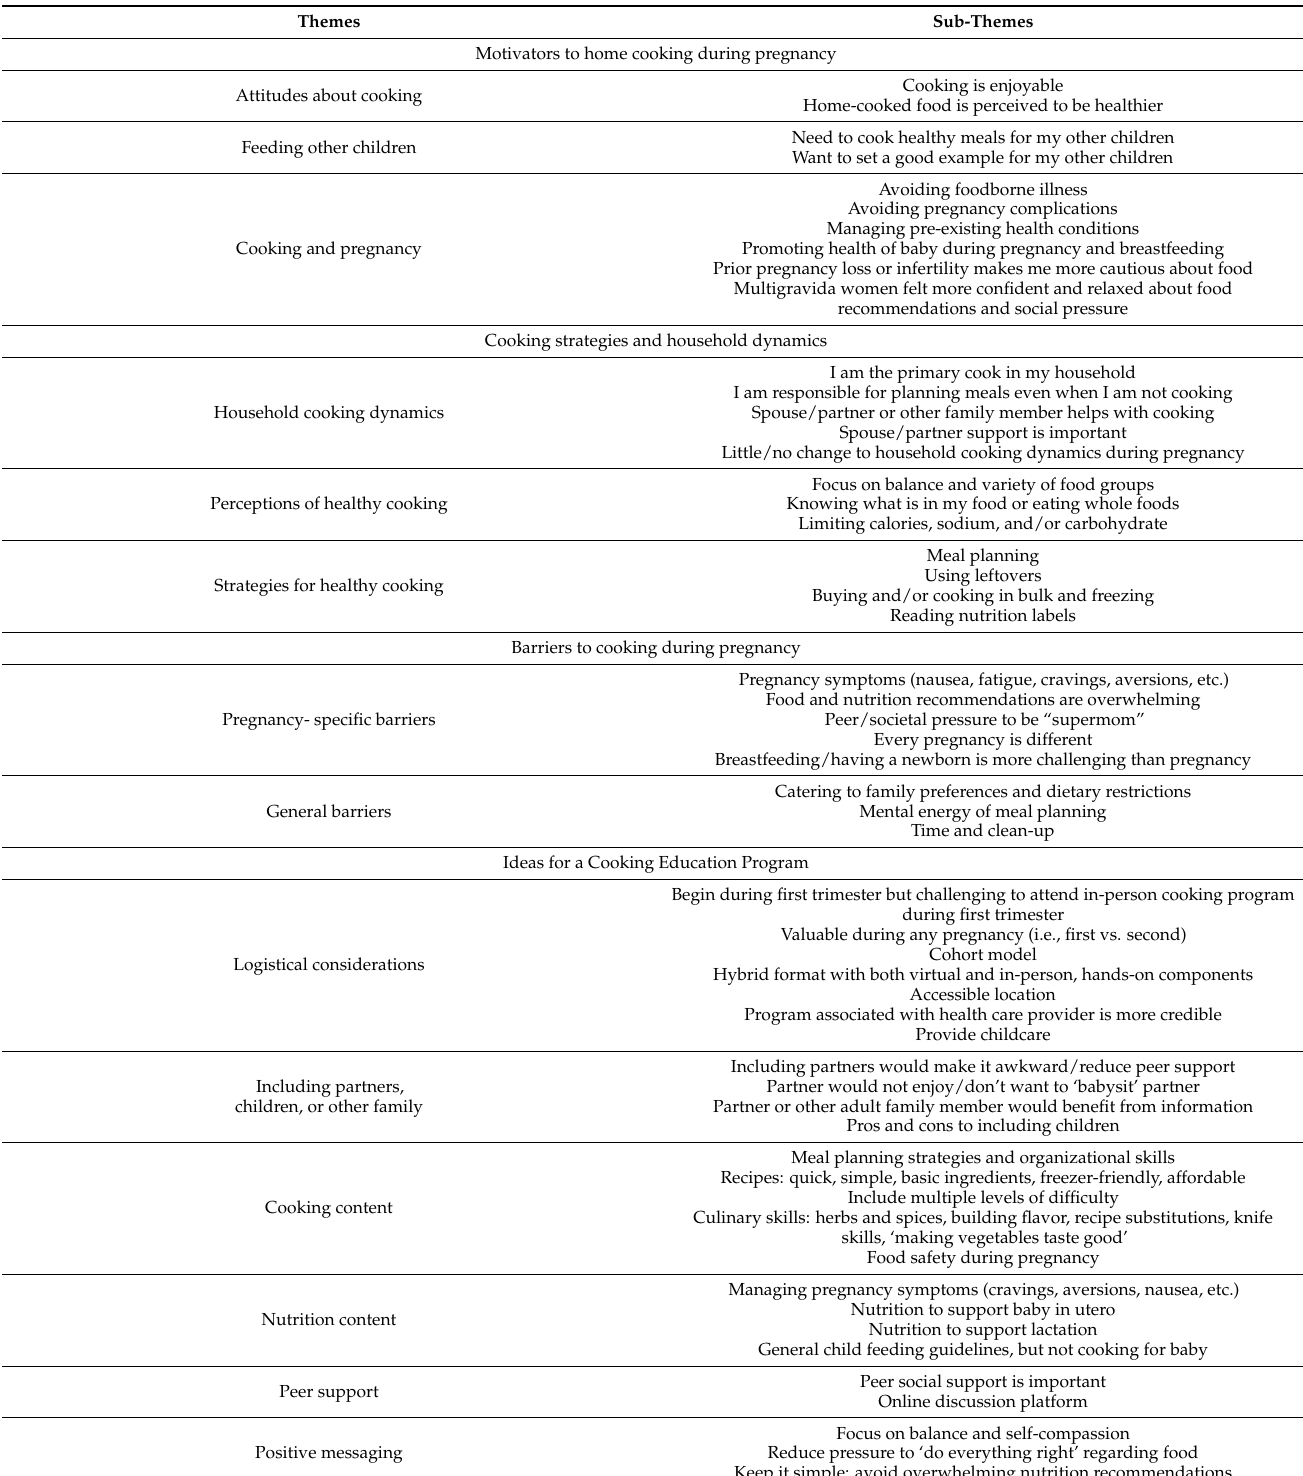
Table 2. Key Focus Group Themes and